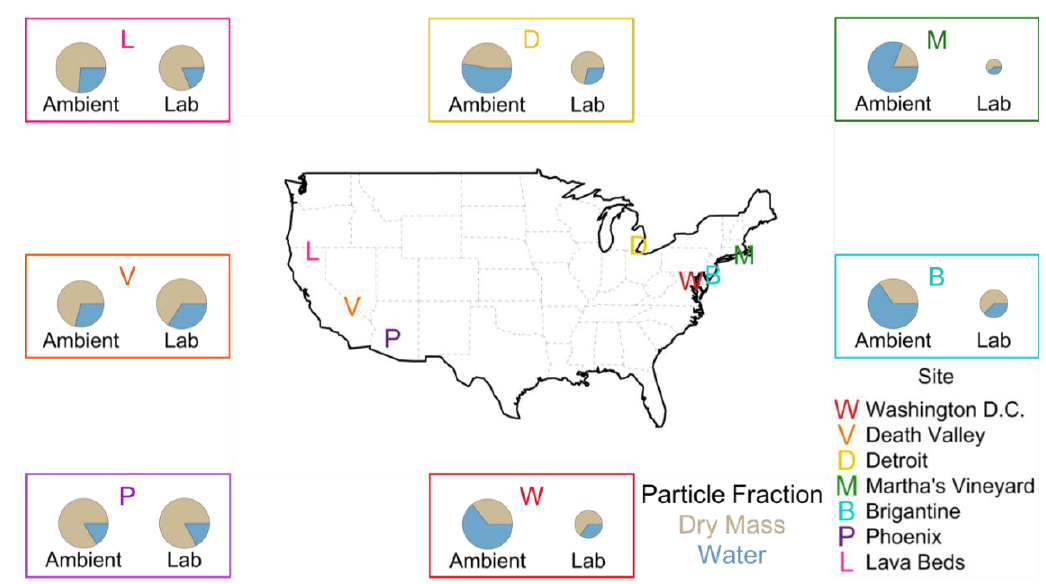
Figure 2. Differences between ambient and laboratory-equilibrated PM 2.5 absolute mass and constituent fractional contributions. Idealized particles are drawn to scale by mass for ambient and laboratory conditions for each city, but not between cities.